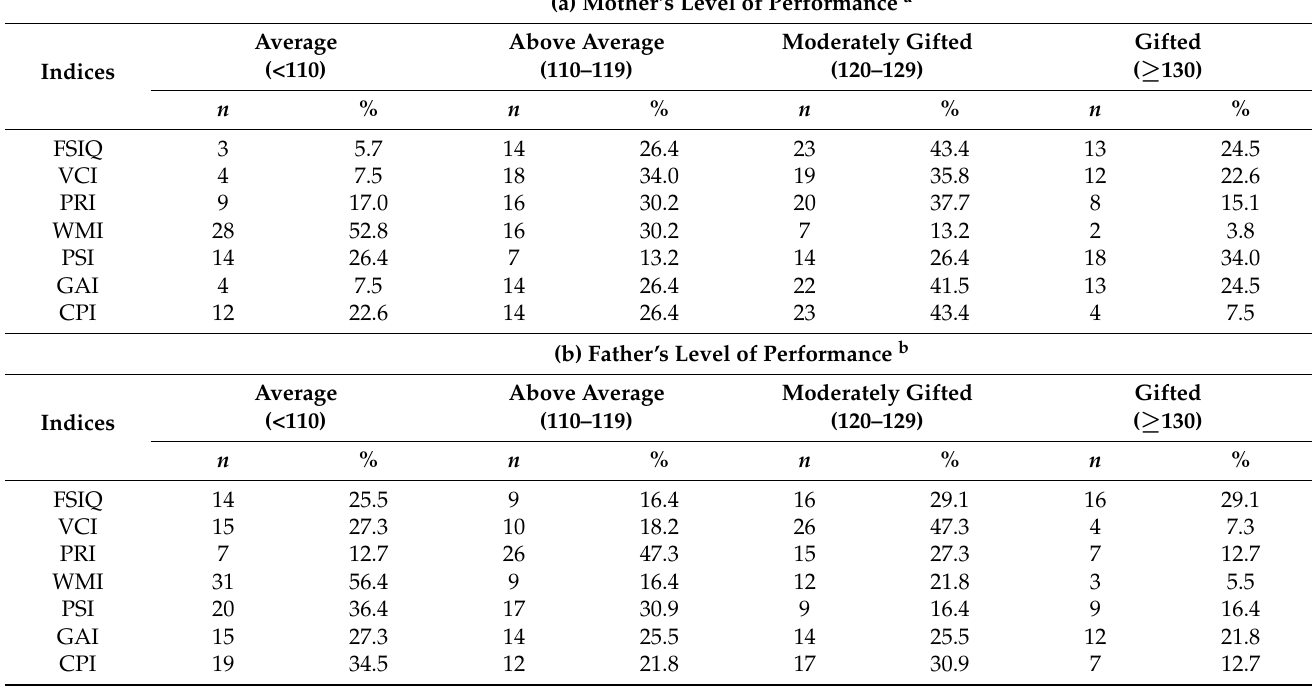
Table 5. Frequency distribution of WAIS-IV indices by (a) mother’s and (b) father’s level of perfor-